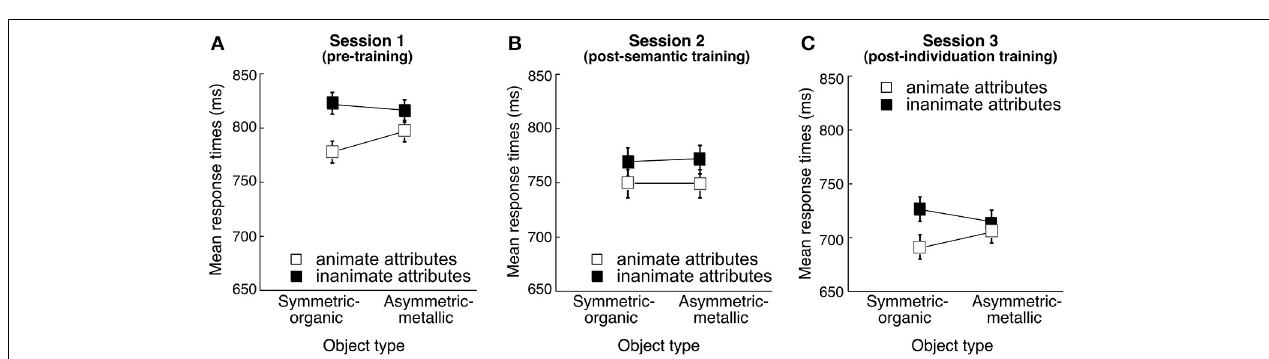
other tasks. Error bars represent the 95% confidence intervals of the training effects across sessions within each group for each object type.